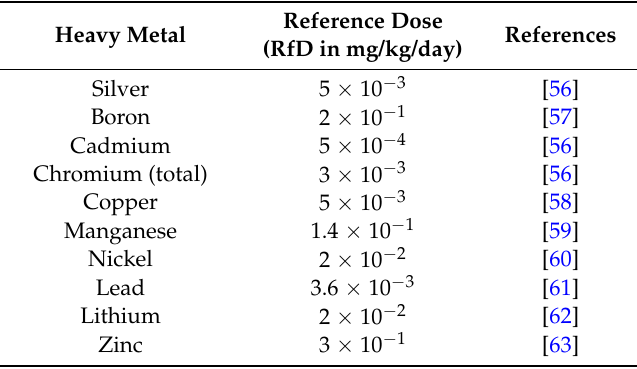
Table 5. Oral reference dose for heavy metals.